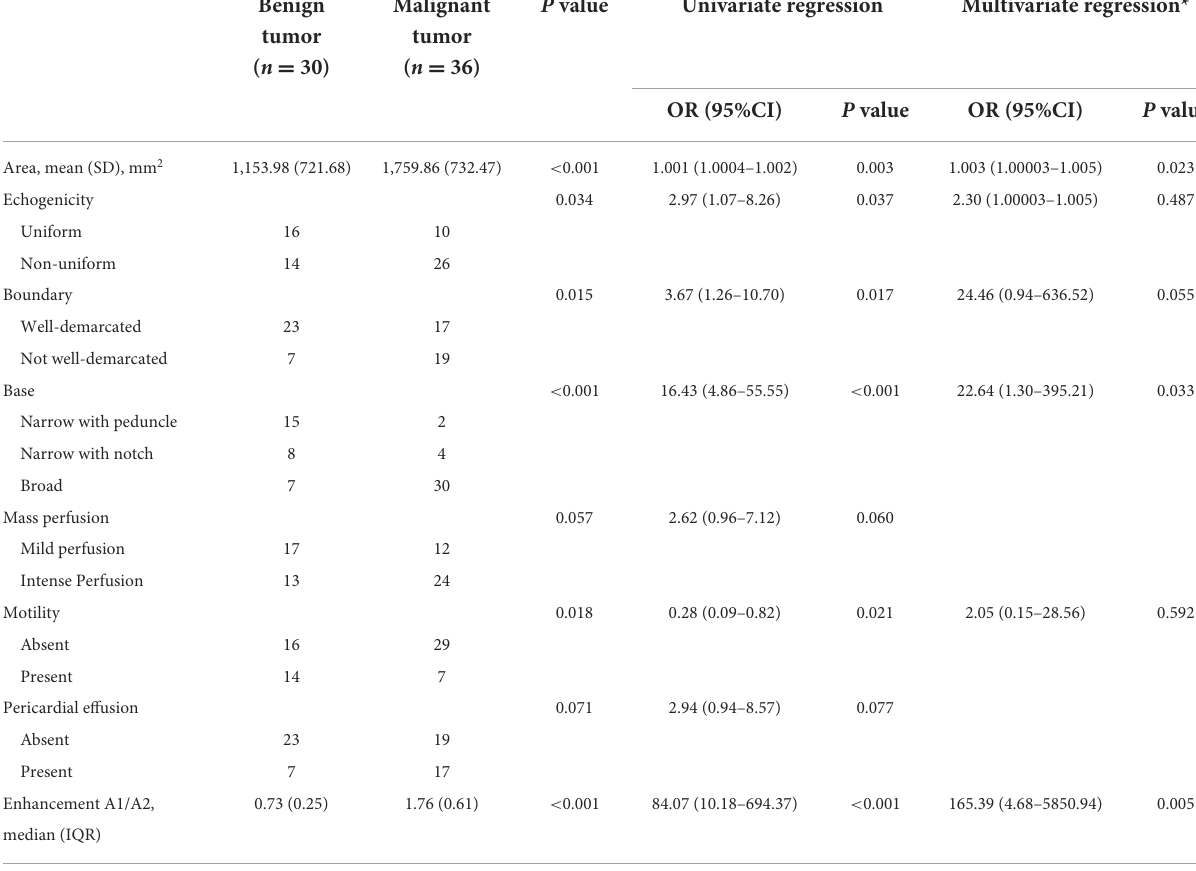
TABLE 4 Comparison of echocardiographic parameters between malignant tumor and benign tumor. P value Univariate regression Multivariate regression* Benign Malignant tumor tumor ( n = 30)